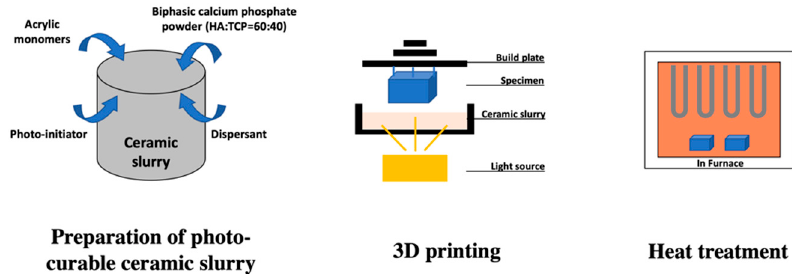
Figure 2. Digital light processing (DLP)-type 3D-printing process for pure HA/TCP scaffold.